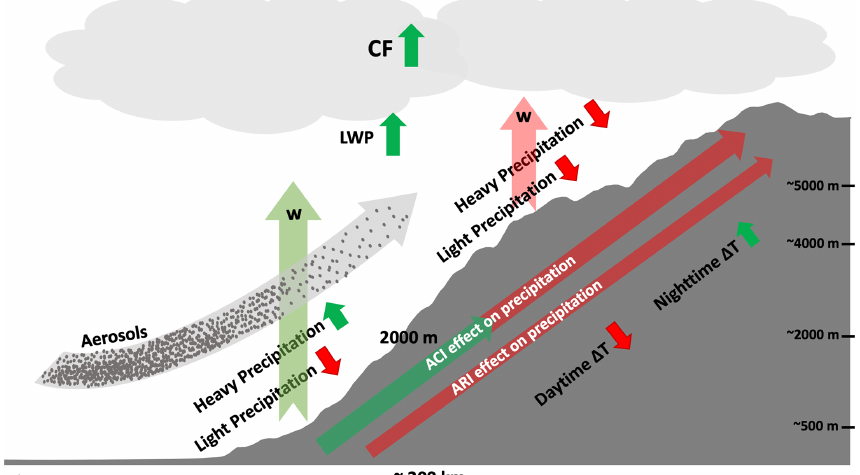
Figure 15. Schematic representing the relative impact of the different effects of aerosols on elevation-dependent precipitation. Green and red arrows represent the increasing and decreasing magnitude of different parameters, respectively. The shaded gray area represents the characteristic elevation of the southern slopes across the central Himalayan